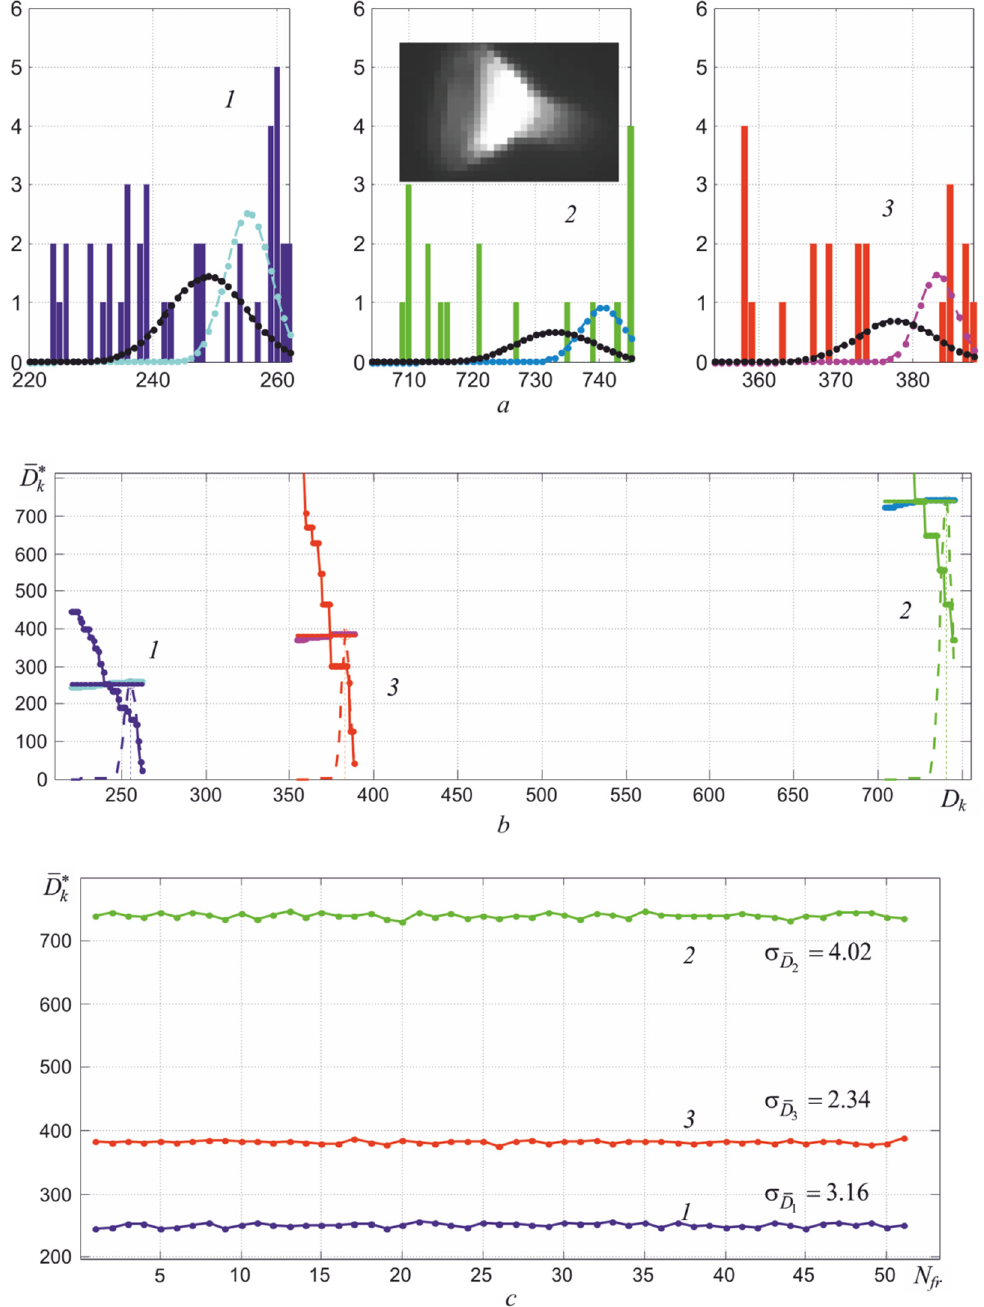
Figure 17. Histograms of counts distribution during registration of heat fluxes generated by a lighting lamp (under conditions z = 90 cm and T r 2 = 1100 ◦ C) for 1, 2, and 3 spectral regions ( a ) and illustration of the process of determining the average value of digital signals D k ( b ), as well as the dependence of the resulting estimates D k on the frame number N fr ( c ).